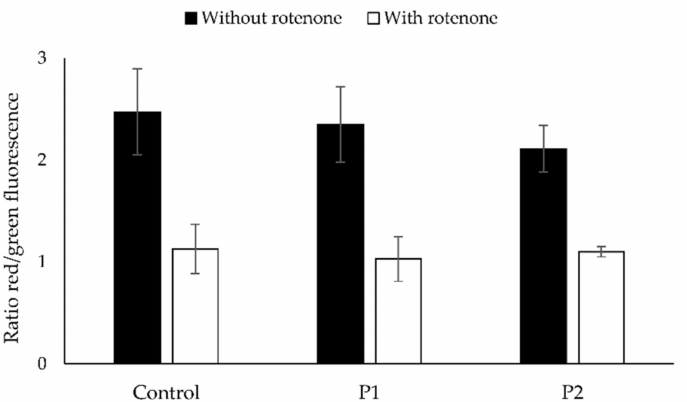
Figure 6. Ratios of red/green fluorescence of both the control sample and the patient samples without and with preincubation with rotenone. Depicted is the average JC-1 ratio ± SD ( n = 10).